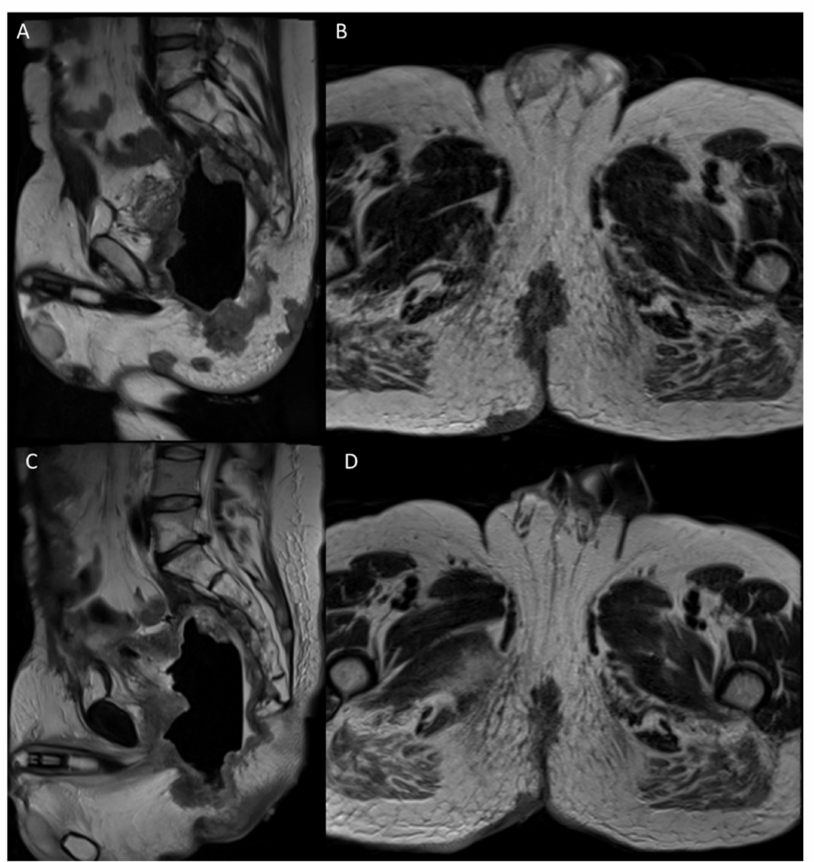
Figure 6. MR images ( A , B ) before treatment of third case and 6 months after ECT treatment ( C , D